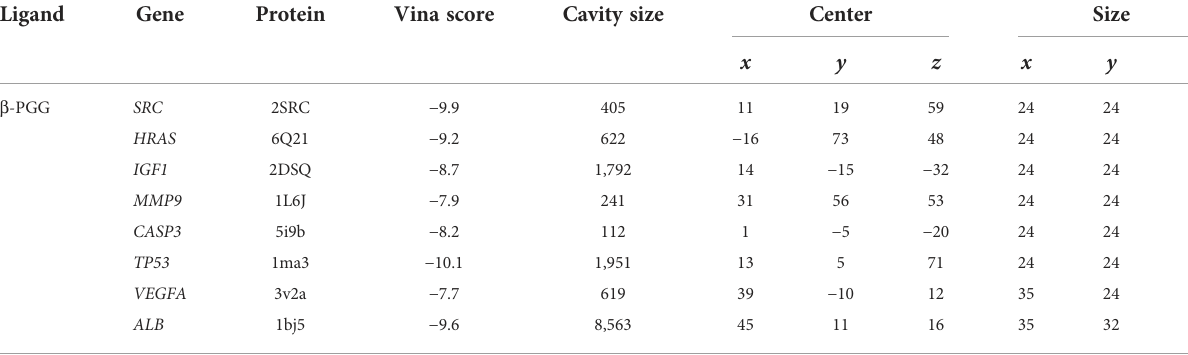
TABLE 2 Molecular docking of the core target genes with PGG.